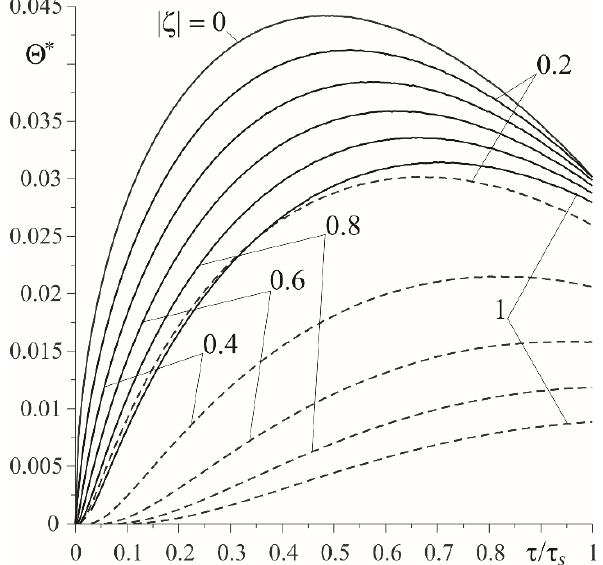
ζ ∗ Θ on the established distances